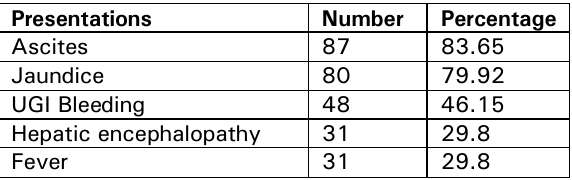
Table 2: Symptomatdogy of the study